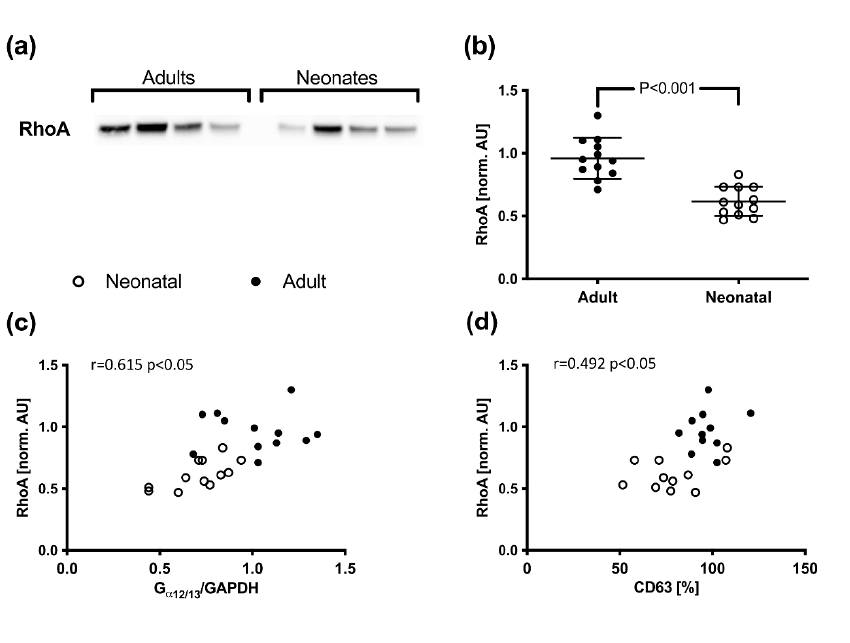
Figure 3. Rho activation in adult and neonatal platelets after stimulation with thrombin (0.5 U/mL). ( a ) Representative blot lanes from Western blot analyses after Rho pull-down from thrombin stim- ulated adult and neonatal platelets. ( b ) Statistical depiction of activated Rho blot-band densities normalized to the average of adult values. Bars show mean ± SD. Statistical difference was deter- mined with Student’s t -test. ( c ) Scatter plot showing positive correlation between Rho activation and G α 12/13 expression. ( d ) Scatter plot showing positive correlation between Rho activation and CD63 expression after thrombin stimulation (0.5 U/mL).